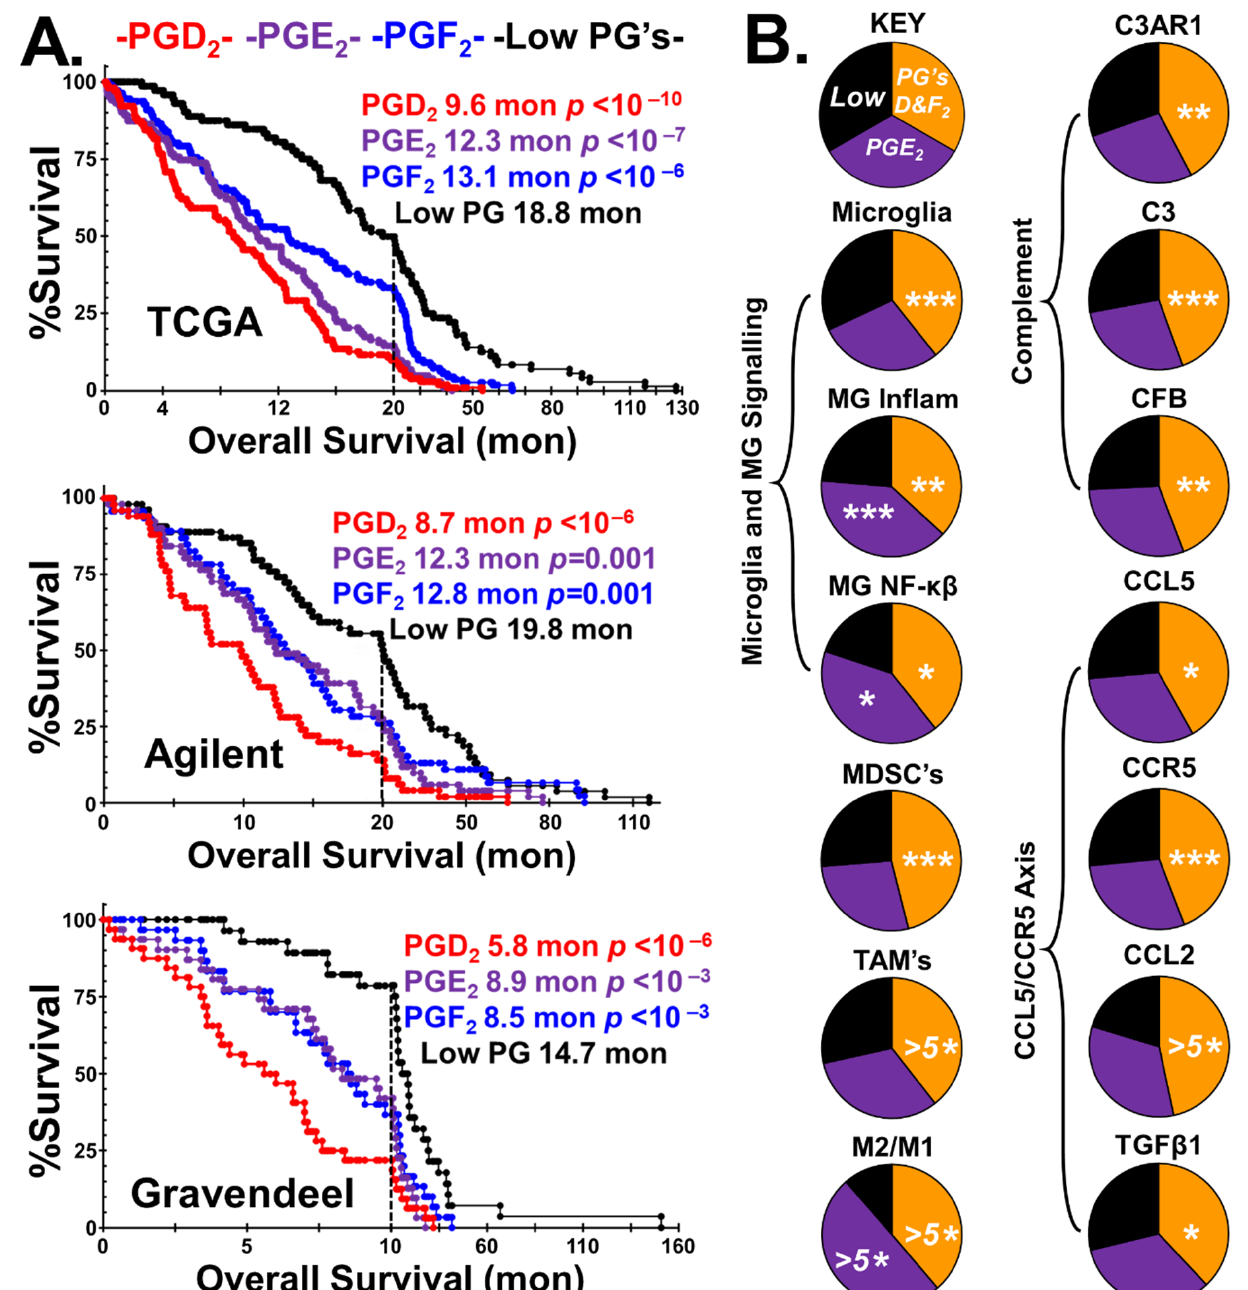
Figure 3. General characteristics of the prostaglandin groups. ( A ) The prostaglandin GBM tumor phenotype’s impact on patient outcome is shown in the Kaplan–Meier survival curves, with the median survival and statistical significance vs. the ‘Low PG’ group indicated. ( B ) The differences between the combined PGD 2 /PGF 2 and PGE 2 groups with the tumor/immune cell phenotype are highlighted. The PGD 2 /PGF 2 group is enriched with microglia, MDSCs, and TAMs, with M2 > M1 polarization. The PGD 2 /PGF 2 group is also enriched with markers of the CCL5/CCR5 axis. Statisti‑ cal significance derived from the t ‑tests when compared to the ‘Low PG’ group are represented by asterisks, p < 0.05 *, p < 0.01 **, p < 0.005 ***, and p < 0.0001 (5 * )